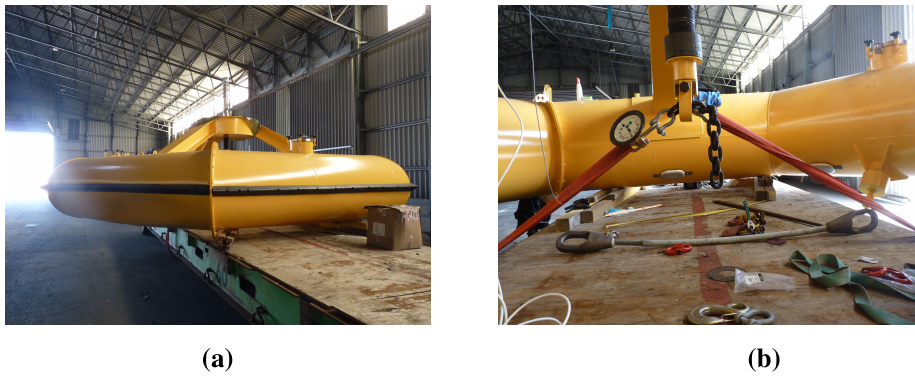
Figure 7. Calibration of strain gauges. ( a ) The buoy stored on a barge at the Lysekil harbor; ( b ) the screw was hooked to the barge via a lifting